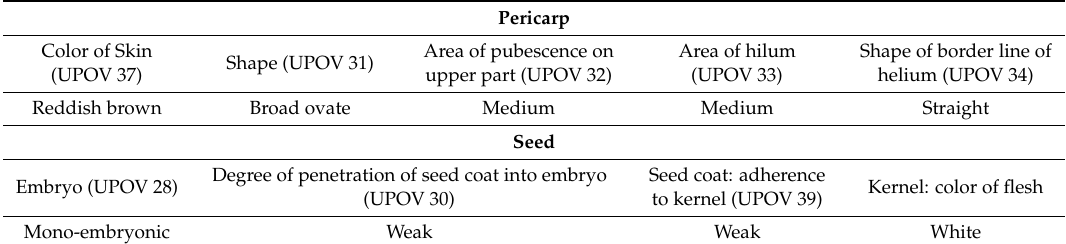
Table 2. Main carpometric characteristics of the fruits observed ( n = 50) according to the International Union for the Protection of New Varieties of Plants (UPOV) [33].